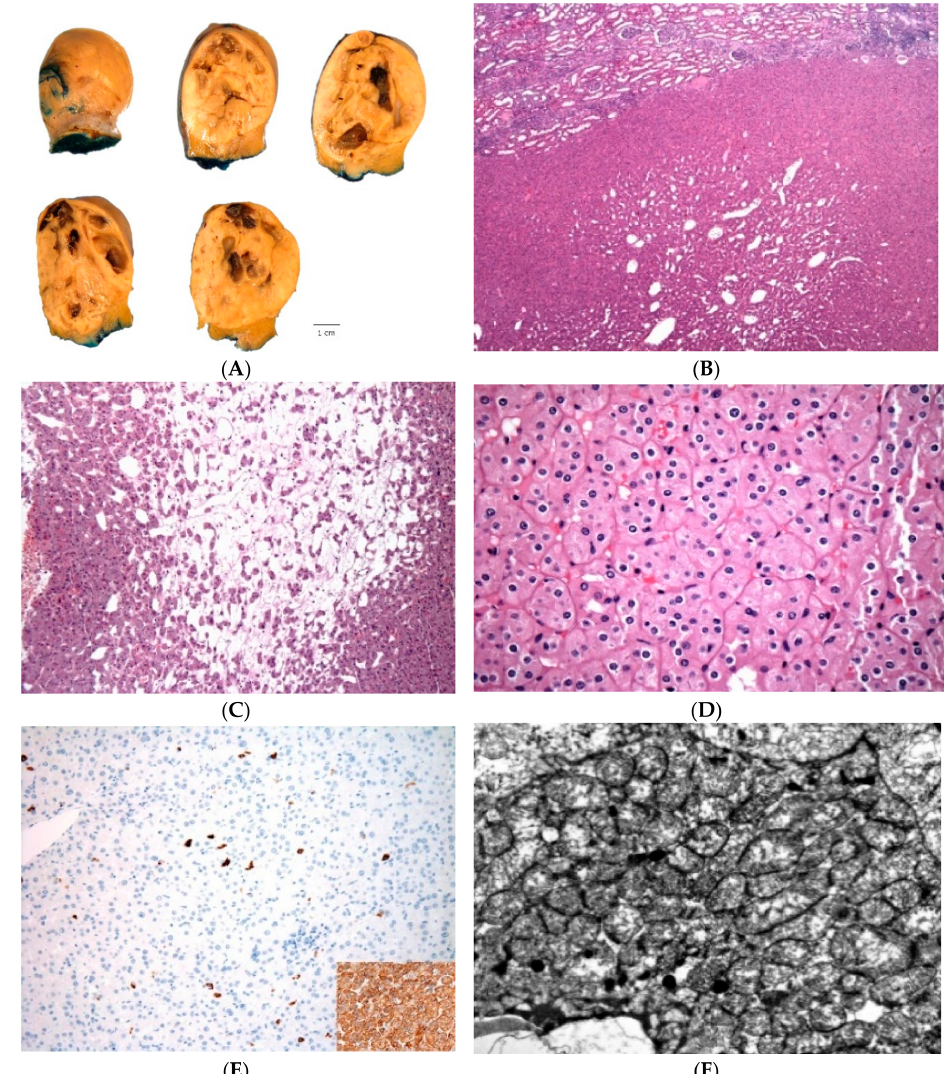
Figure 4. Low-grade oncocytic tumor (LOT) of kidney grossly shows tan to yellow cut surface ( A ). LOT is a non-encapsulated tumor showing mostly solid growth; focal tubular-tubuloreticular patterns can be present more centrally ( B ). There are frequent, sharply delineated edematous areas containing single cells and irregularly cell cords ( C ). The eosinophilic cells show ‘low-grade’, round to oval nuclei, often with delicate perinuclear clearing ( D ). On immunostains, CD117 is typically negative and there is di ff use reactivity for CK7 (insert) ( E ). Electron microscopy shows densely packed intracytoplasmic mitochondria ( F